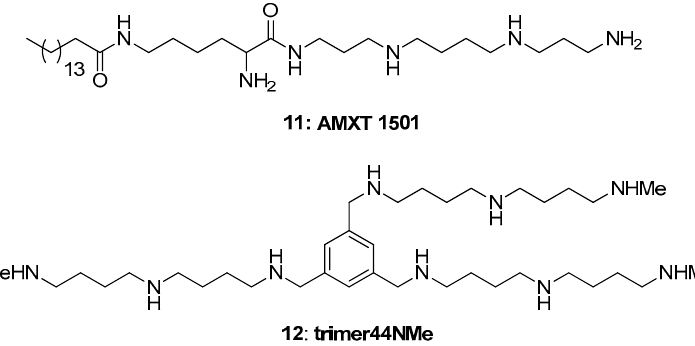
Figure 8. Structures of PTI compounds 11 and 12 .